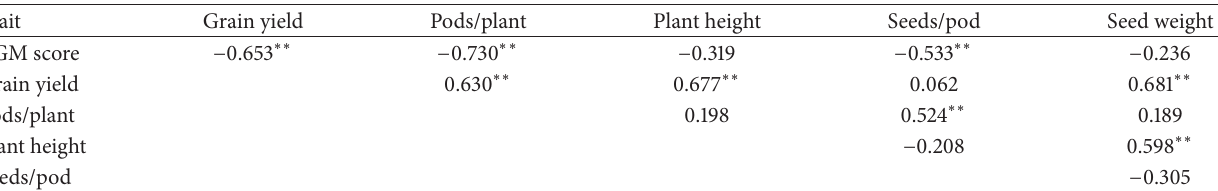
Table 4: Correlation coefficient values of BGM disease intensity with grain yield and yield components in BGM susceptible chickpea variety “BARIchhola-1”. Trait Grain yield Pods/plant Plant height Seeds/pod Seed weight BGM score − 0.653 ∗∗ − 0.730 ∗∗ − 0.319 − 0.533 ∗∗ − 0.236 Grain yield 0.630 ∗∗ 0.677 ∗∗ 0.062 0.681 ∗∗ Pods/plant 0.198 0.524 ∗∗ 0.189 Plant height − 0.208 0.598 ∗∗ Seeds/pod − 0.305